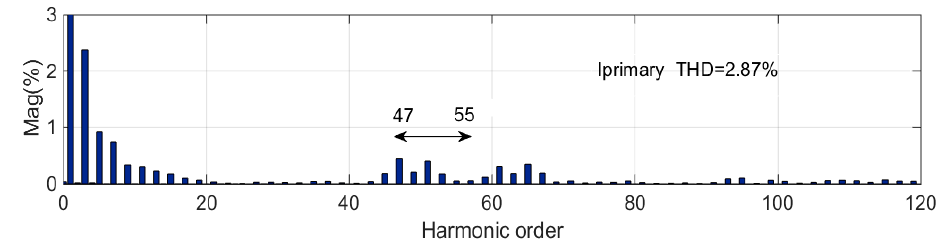
Figure 21. Fourier analysis of transformer primary current.